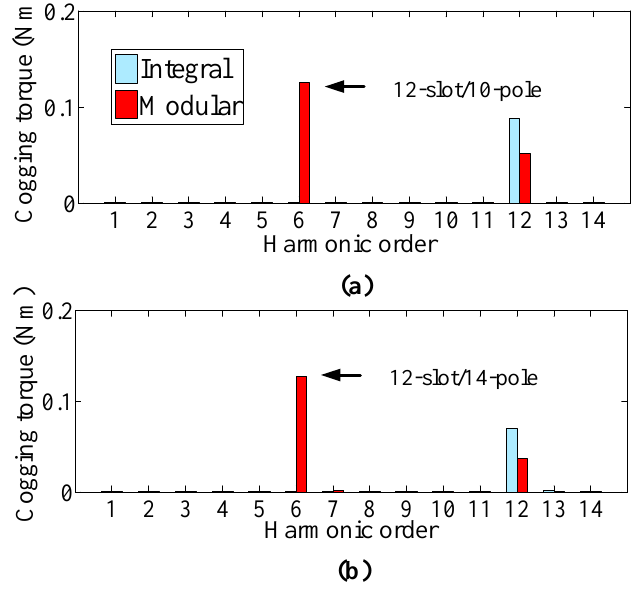
Figure 11. Cogging torques harmonics. ( a ) 12s/10p; ( b ) 12s/14p.